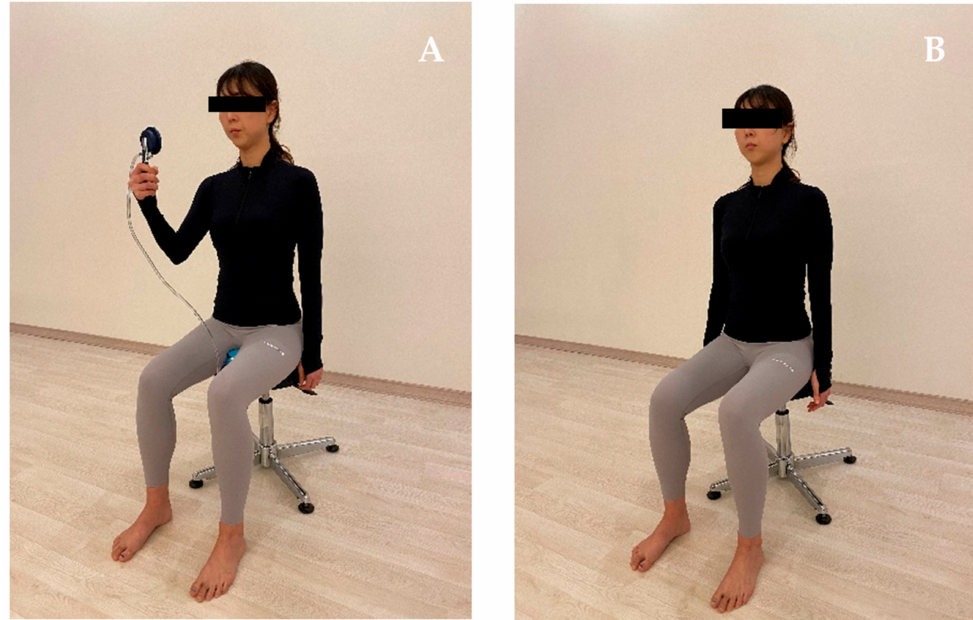
Figure 1. Performing pelvic floor muscle contraction with different feedback methods. ( A ) Pressure biofeedback. ( B ) Verbal